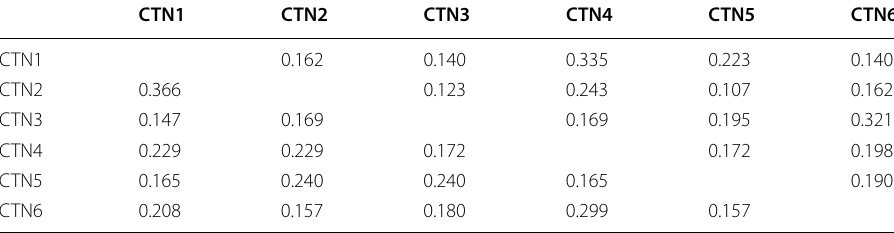
Table 7 Relation matrix with the values of